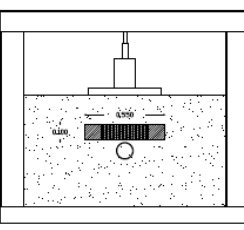
Figure 3. The experimental set up for the embedded EPS Block over the pipe model